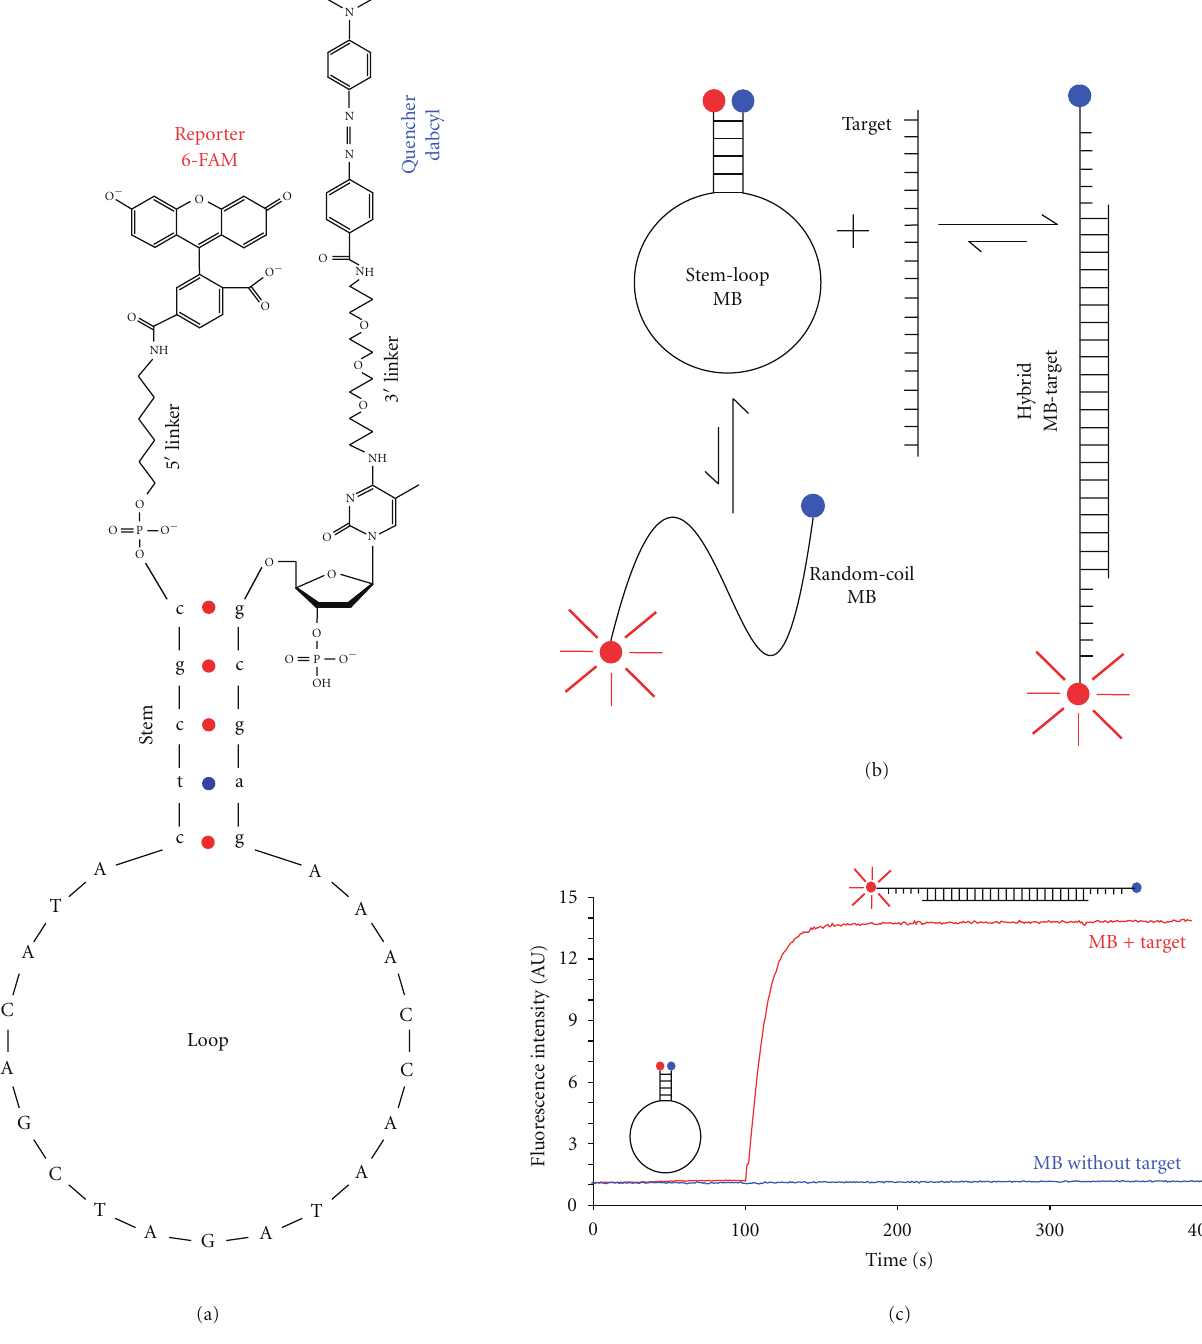
Figure 1: Structure and function of MB. (a) Stem-loop hairpin structure of a MB showing its four structural components: loop, stem, quencher, and reporter. The chemical structure of the linkers is drawn according to the manufacturer (Integrated DNA Technologies, Iowa, USA). (b) Mechanism of MB function. A MB in a solution containing both MB and target could be in three states: free in a stem-loop hairpin conformation, hybridized with it target, or unbound in a random-coil conformation. The random-coil conformation of the MB contributes to the background. (c) Fluorescence intensity. The blue line shows the fluorescence intensity for a MB in solution (50nM) during 400 seconds (background), and the red line corresponds to the addition (100 seconds) of a target oligonucleotide (500nM) that hybridize the MB at the loop region. An increase in fluorescent intensity of approximately thirteenfold is observed. The reporter is represented with a red circle and the quencher with a blue. UA means arbitrary